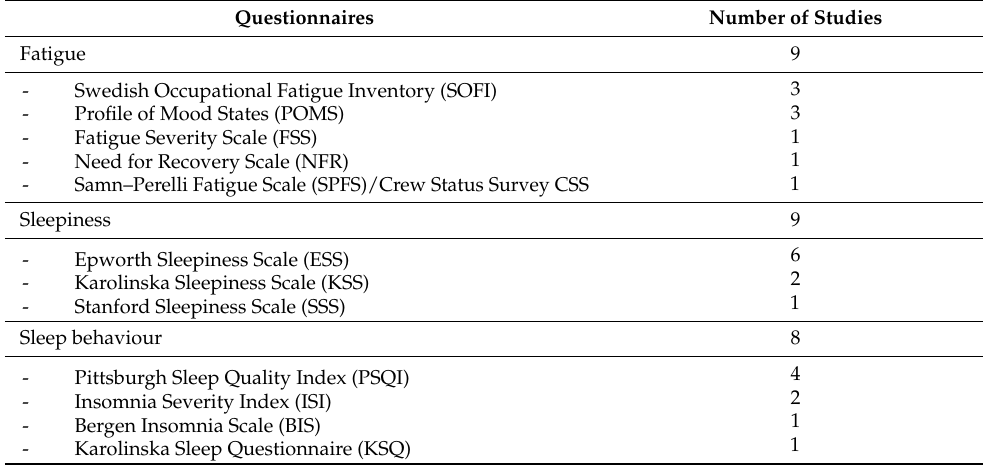
Table 2. Overview of questionnaires used on